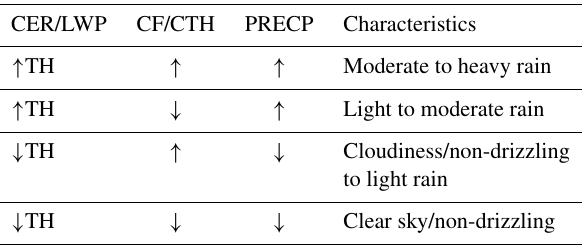
Table 3. A summary of the different states of cloud properties and the corresponding effects on precipitation over the region.